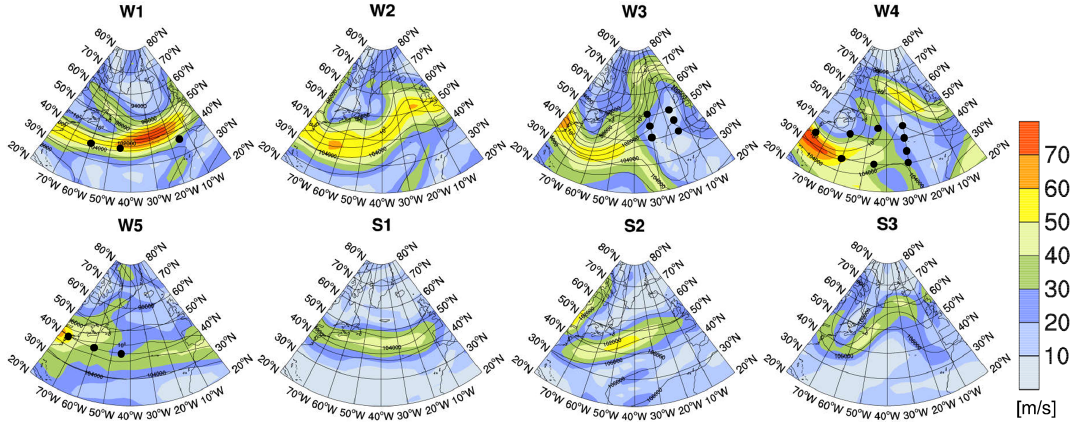
Figure 2. Geopotential height (black contours in gpm) and wind velocities in metres per second (ms − 1 , colour bar) at 250hPa for five representative winter weather situations (W1–W5) and three summer situations (S1–S3) as simulated with EMAC using the classification of Irvine et al. (2013). The black dots mark the regions discussed in Sect. 4.2 and listed in Table A1. Please note that the maps in Fig. 2 show a somewhat larger area for a better representation of the weather patterns than the maps showing the CCFs in Figs. 3, 7, 8, 11, and